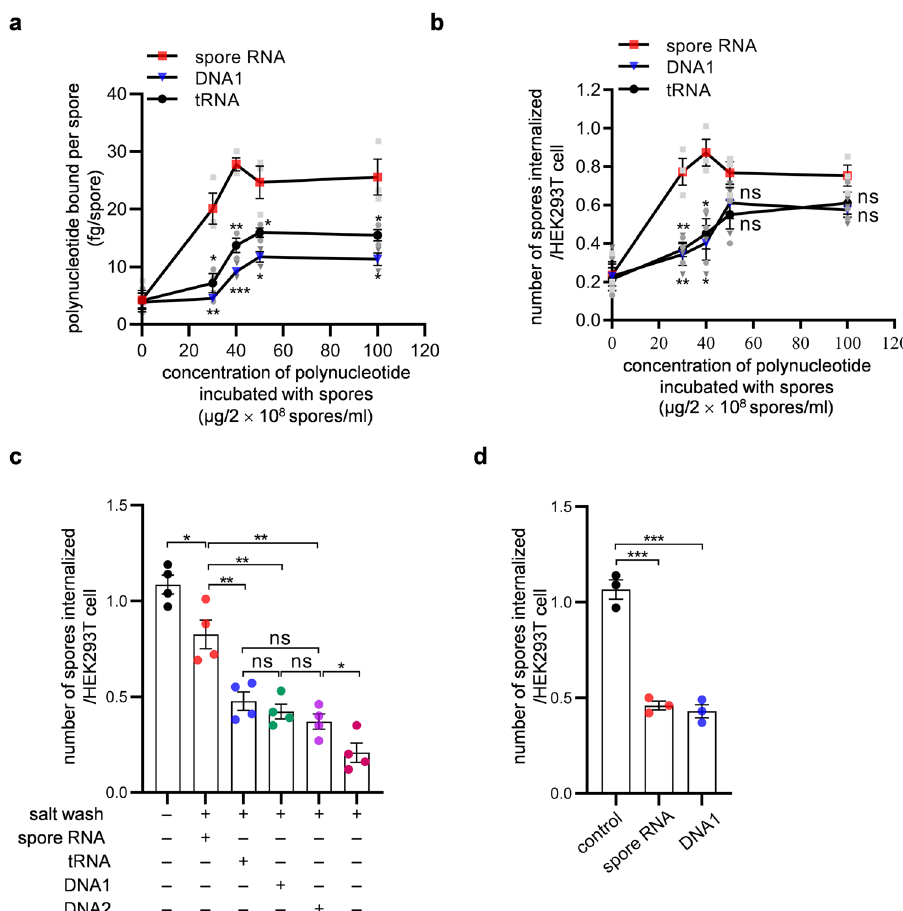
Fig. 4 Internalization of spores in HEK293T cells is induced by polynucleotides. a Amounts of polynucleotides bound to high-salt-washed spores. High- salt-washed spores were incubated with spore wall-derived RNA (spore RNA), tRNA, or DNA1 at the indicated concentrations. Polynucleotides bound to the spores were eluted in a high-salt solution and their amounts were measured. b Internalization of polynucleotide-bound high-salt-washed spores in HEK293T cells. High-salt-washed spores incubated with spore wall-derived RNA (spore RNA), tRNA, or DNA1 at the indicated concentrations were incubated with HEK293T cells. Mean numbers of spores internalized per HEK293T cell are shown. c Internalization of high-salt-washed spores (2 × 10 8 ) incubated with ( + ) or without ( − ) 40 µ g of indicated polynucleotides in HEK293T cell. As a control, untreated spores were incubated with HEK293T cells (salt wash − ). d Spore internalization in HEK293T cells in the presence or absence (control) of the indicated polynucleotides. Data were presented as the mean ± SEM. Statistical signi fi cance was determined by two-tailed unpaired Student ’ s t -tests. For a , b , Student ’ s t -tests was performed between spore wall- derived RNA and tRNA or DNA1 data. n = 3 ( a , b , d ), n = 4 ( c ). * P < 0.05; ** P < 0.01; *** P < 0.001; ns not signi fi cant ( P ≥